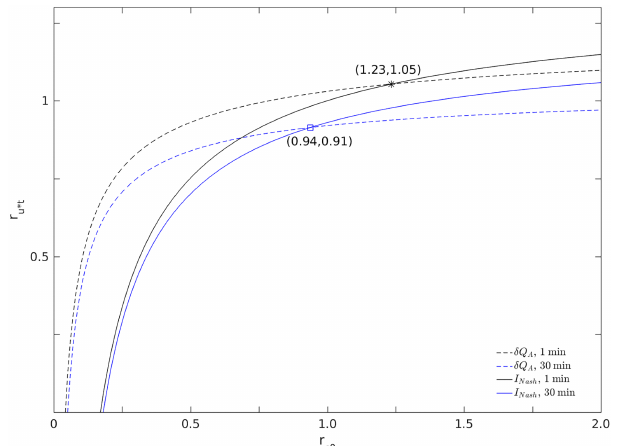
Figure 9. (a) Parameter PDF p(r u and r u . Along ∗ t 0 fluxes; (b) as (a) but for p(r c 30min averaged saltation